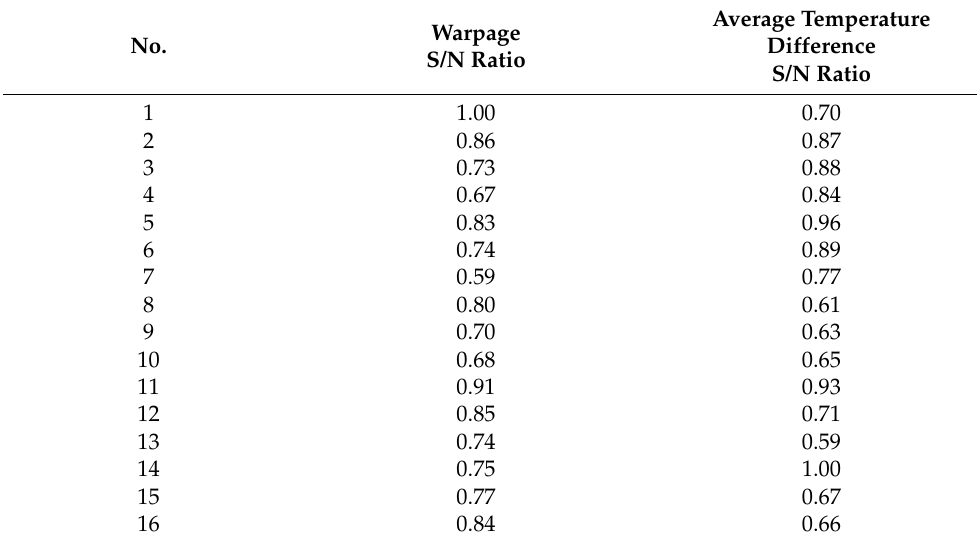
Table 14. Variance Analysis of Average Temperature Difference.